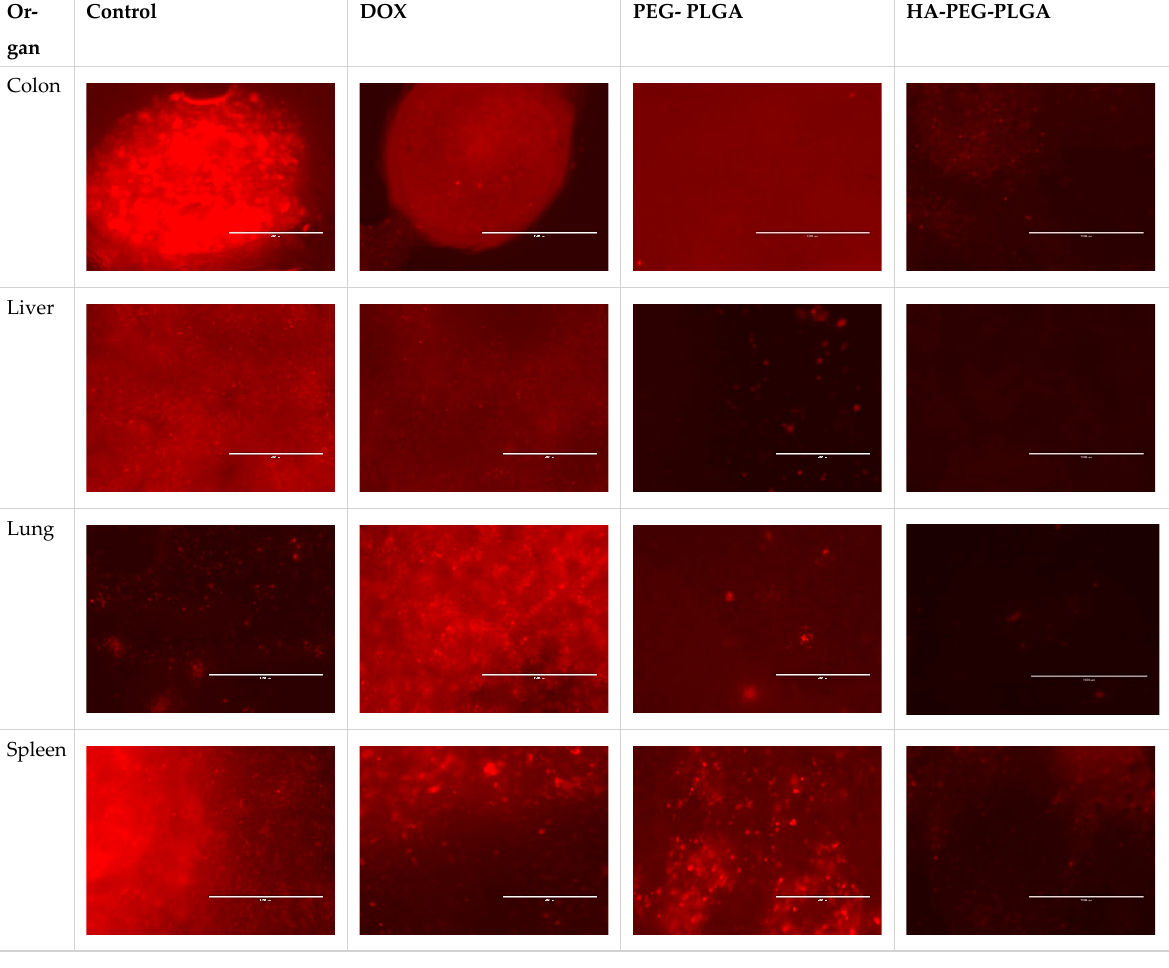
Figure 6. Comparison of the metastatic lesions found in the PEG-PLGA DOX group and the HA- PEG-PLGA- DOX group using fluorescent microscopy.